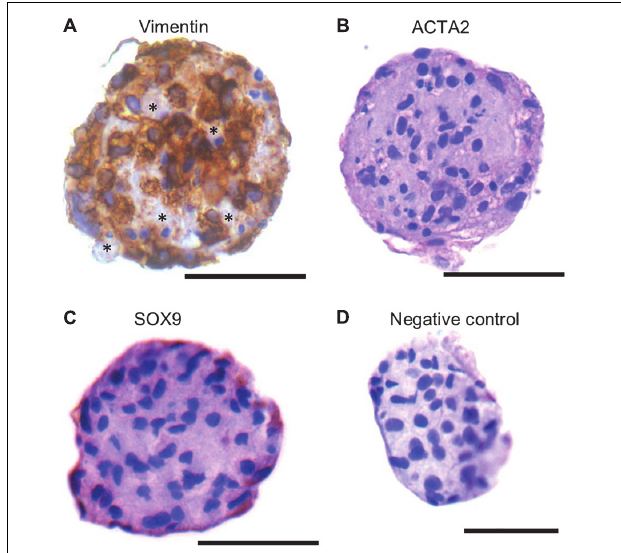
FIGURE 7 | Mesenchymal cell markers in SSCLCs Immunohistochemical analysis of Vimentin (A) , ACTA2 (B) , SOX9 (C) and negative control (D) . Scale bar 50 µ m. Stars represent Vimentin negative area or cells in